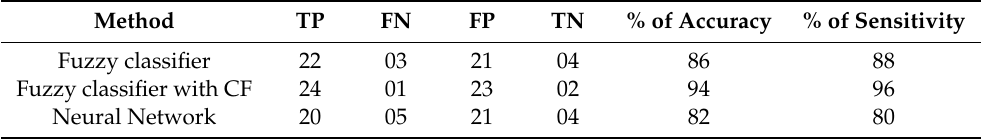
Table 9. PV panels classification test results.